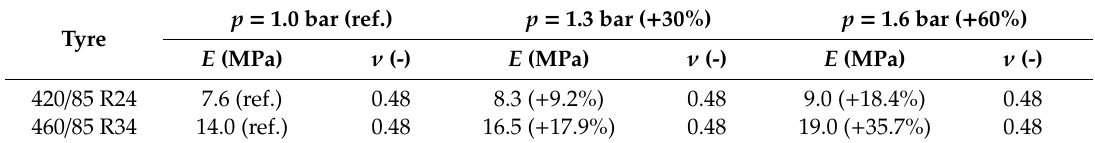
Table 4. Values of Young’s moduli and Poisson’s ratios for the finite elements method (FEM) simulations. The coe ffi cients related to 1.0 bar and 1.6 bar were obtained by converging experimental and FEM results; the coe ffi cients at 1.3 bar are the average between the coe ffi cients at the other pressures. p = 1.0 bar Tyre